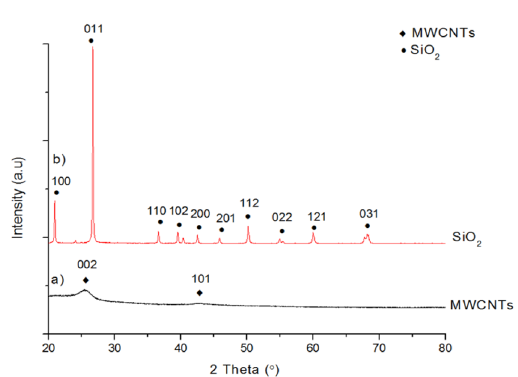
particles and b) MWCNTs. 2